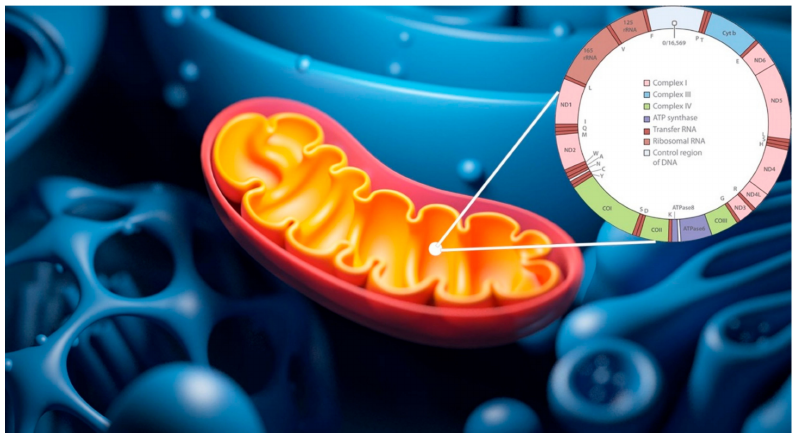
Figure 2. Revised Cambridge Reference Sequence (rCRS) reference mtDNA sequence. Figure shows main genomic features of Revised Cambridge Reference Sequence (rCRS), available as sequence number NC_012920 in the GenBank RefSeq